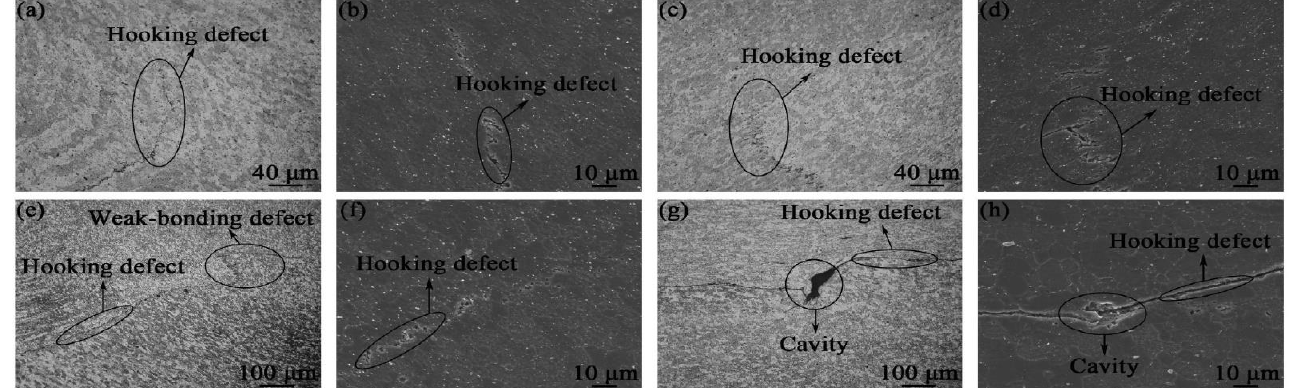
Figure 11. Al-li 2195-T8 build fabricated with single pass and flared tool pin having three concave arc grooves: ( a ) build fabricated at 800 rpm; ( b ) build fabricated at 900 rpm; ( c ) build fabricated at 1000 rpm. (reprinted from [62] with permission from Elsevier).